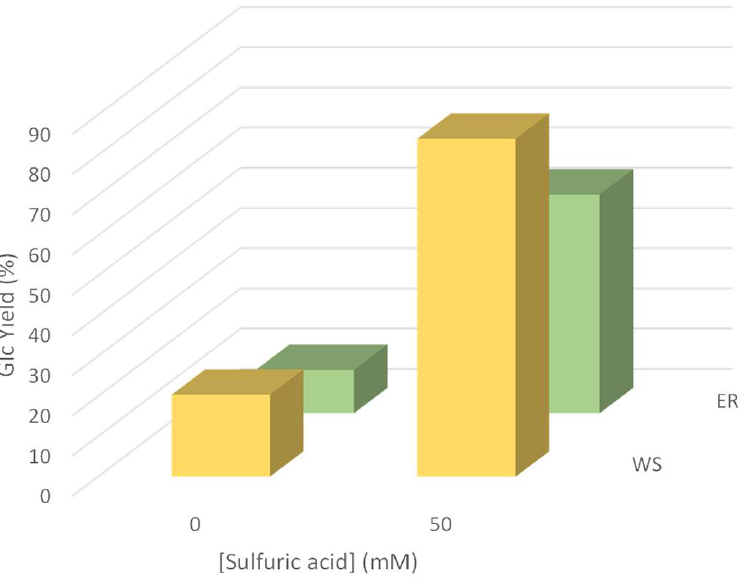
Figure 9. Comparison of enzymatic saccharification of ethanol–water organosolv pulp obtained at 140 ◦ C without (0) or with 50 mM sulphuric acid (50) as catalyst for wheat straw (WS) and eucalyptus residues (ERs).